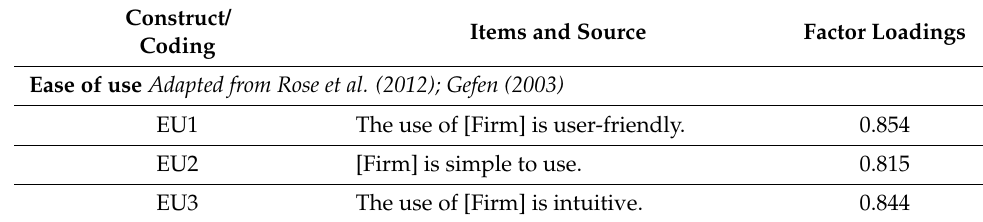
Table 2. Constructs, items, coding and factor